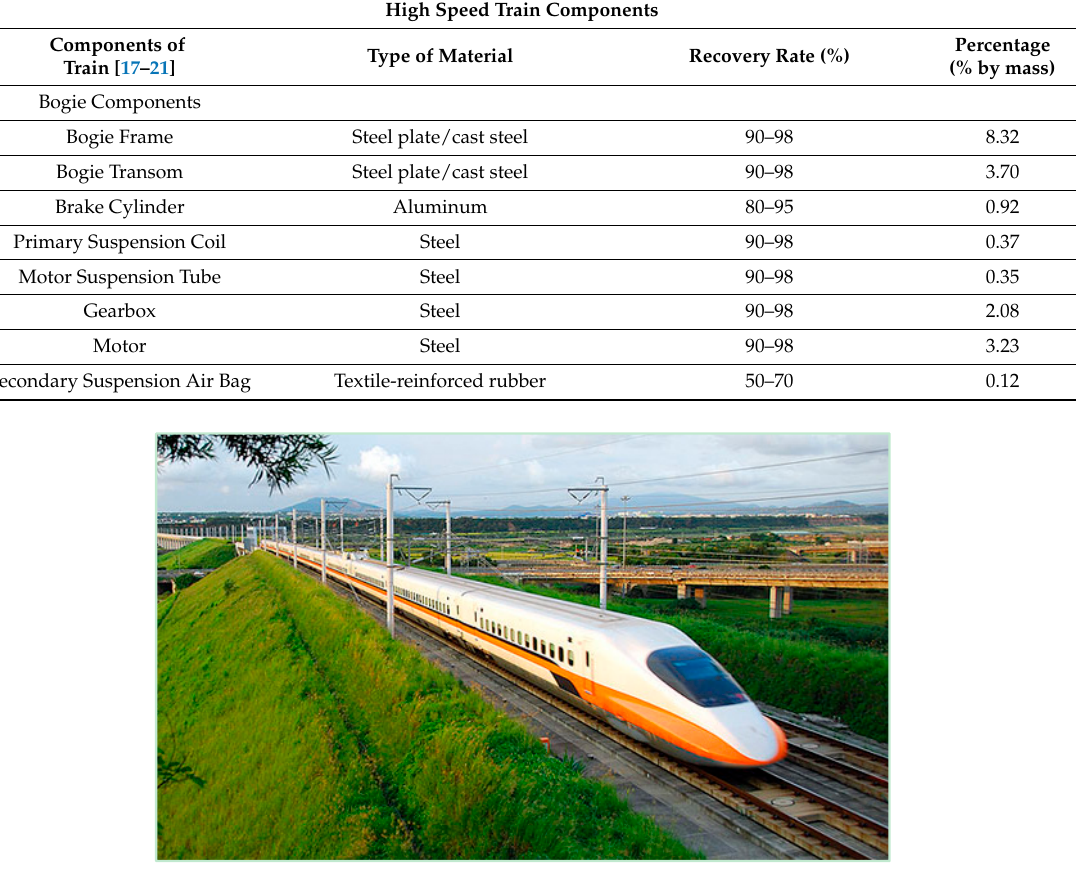
Figure 3. High-speed rail (Taiwan 700T).